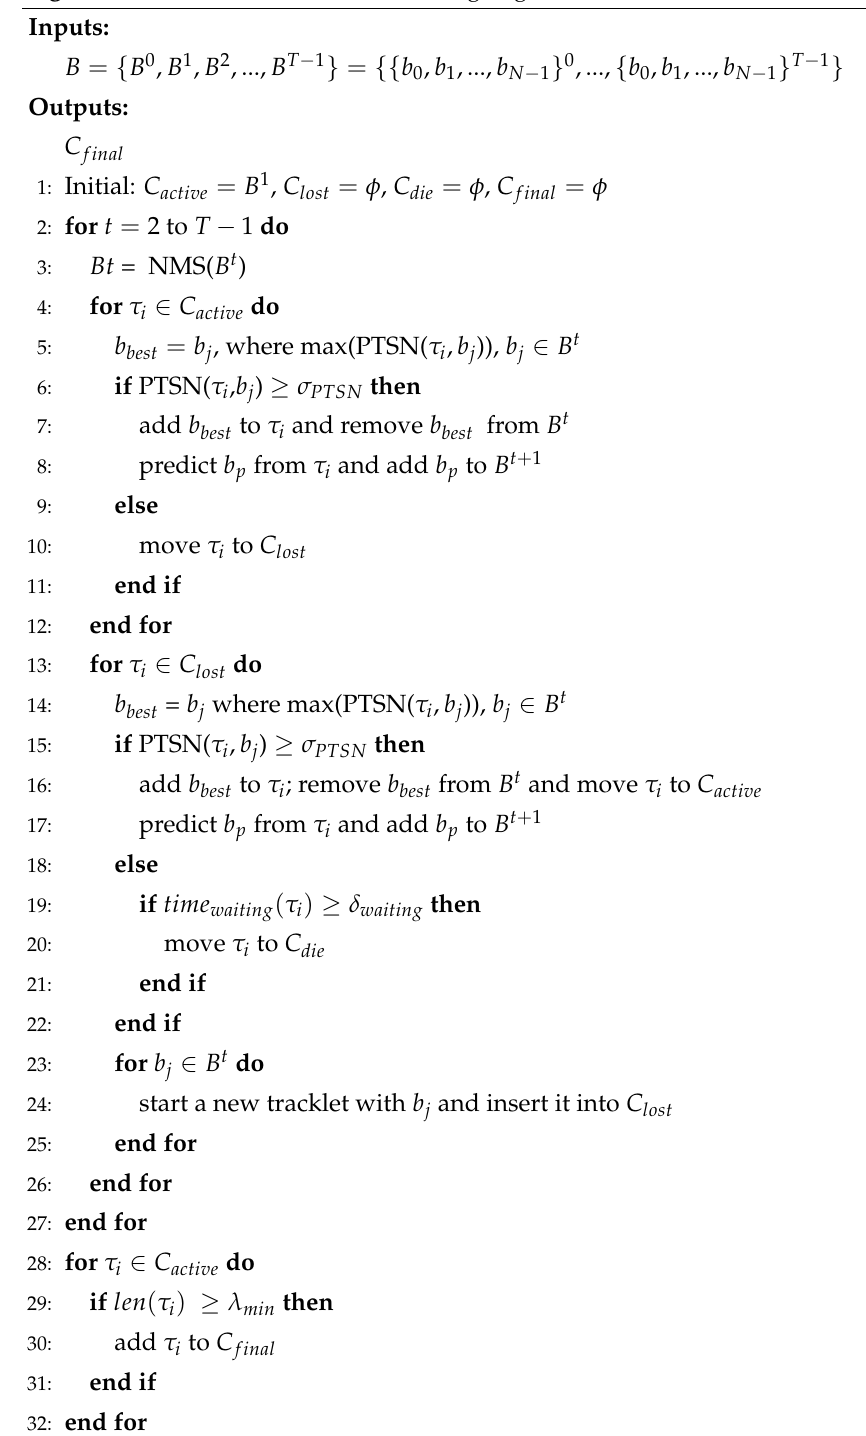
Algorithm 1 Multi-State Online Matching